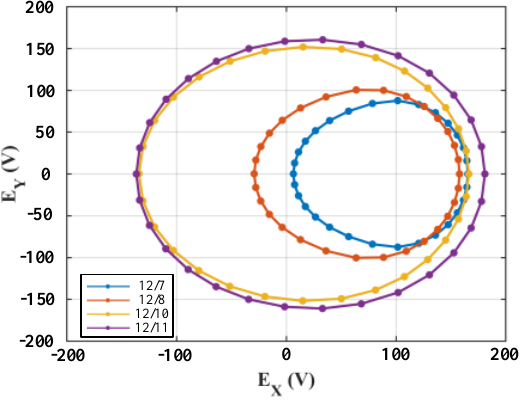
Figure 12. Back EMF vector trajectory of four cases by FEM.